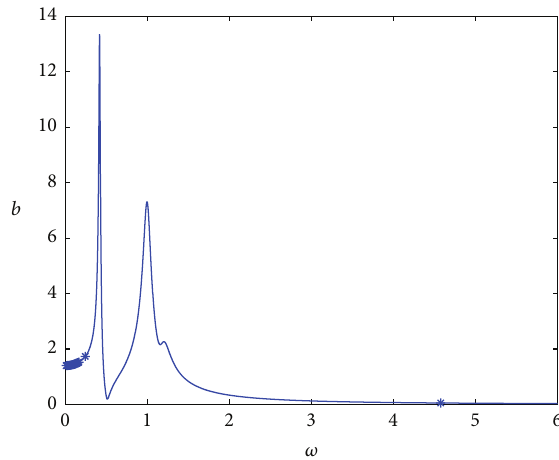
Figure 5: Schematic of codimension-two grazing bifurcation points for 𝑛 = 1 .